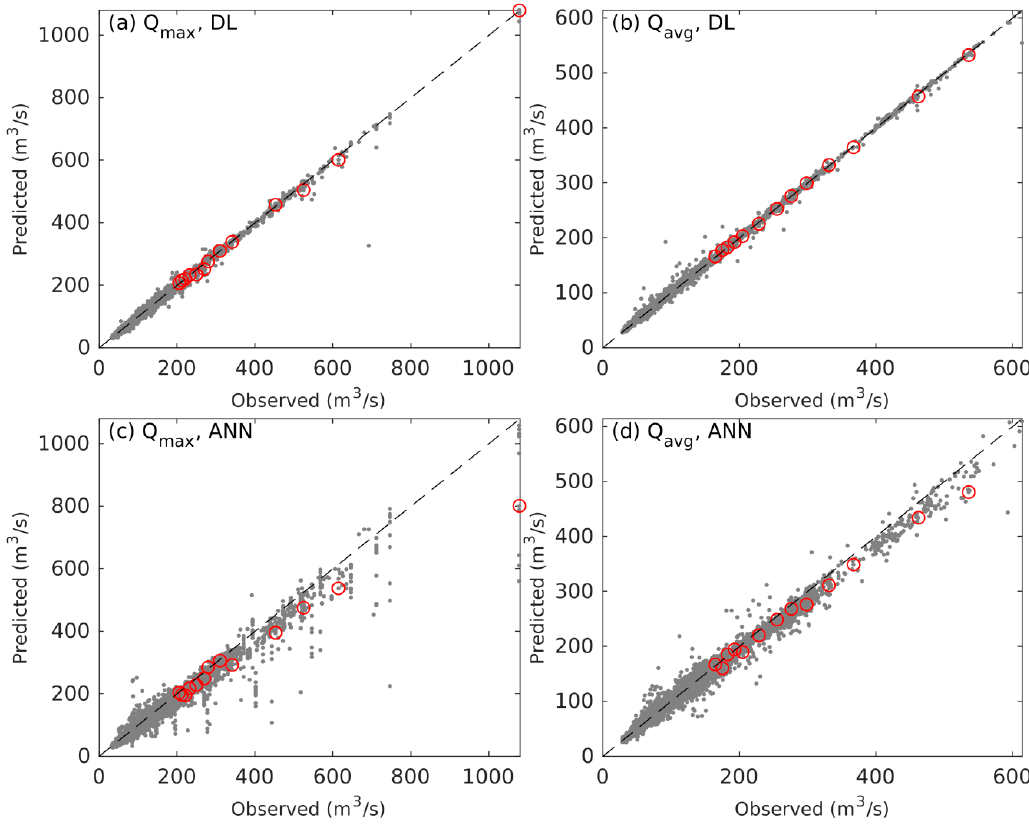
Figure 10. ( a ) Comparison between observed and predicted Q max for flow station 1 and the DL model. ( b ) Same as ( a ) for the average flow Q avg . ( c , d ) same as ( a , b ) for the ANN model. Red open circles define examples plotted in Figure 11. Table 5. Summary of errors for data-driven weather-runoff forecast models. The testing subset was used for computing these indexes.